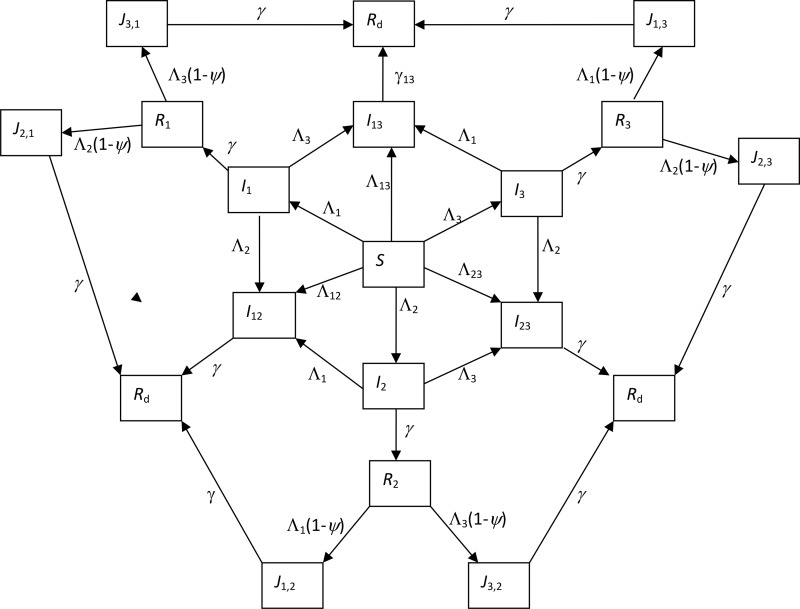
Flow chart of the three-strain SIRS epidemic model.Solid arrows indicate transitions. Expressions next to arrows show the per capita flow rate between compartments. Births and deaths, and transitions from the recovered to the susceptible are not shown. Variables and parameters are explained in Tables 1 and 2. Triple infection is ignored by assuming that, once infected with two strains (either concurrent or sequential), no one can be infected by the third strain.